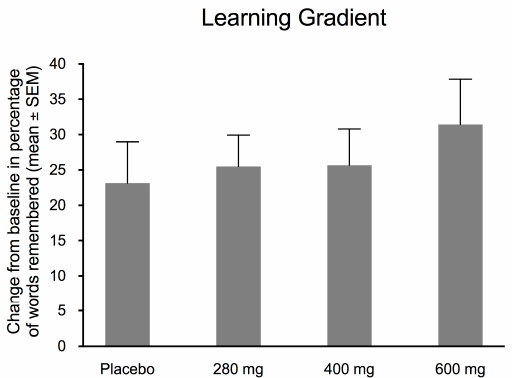
Figure 2. Learning gradient as the percentage of words remembered per trial after intake of daily doses of 0, 280, 400 and 600 mg of fibroin protein enzymatic hydrolysate (FPEH) for 3 weeks is exhibited on the y -axis. The data are presented as mean values with the standard error of the mean (SEM). On the basis of ANOVA ( F = 2.8164; df total = 62; p = 0.7440), the learning gradient changes with increasing dose were not statistically significant.